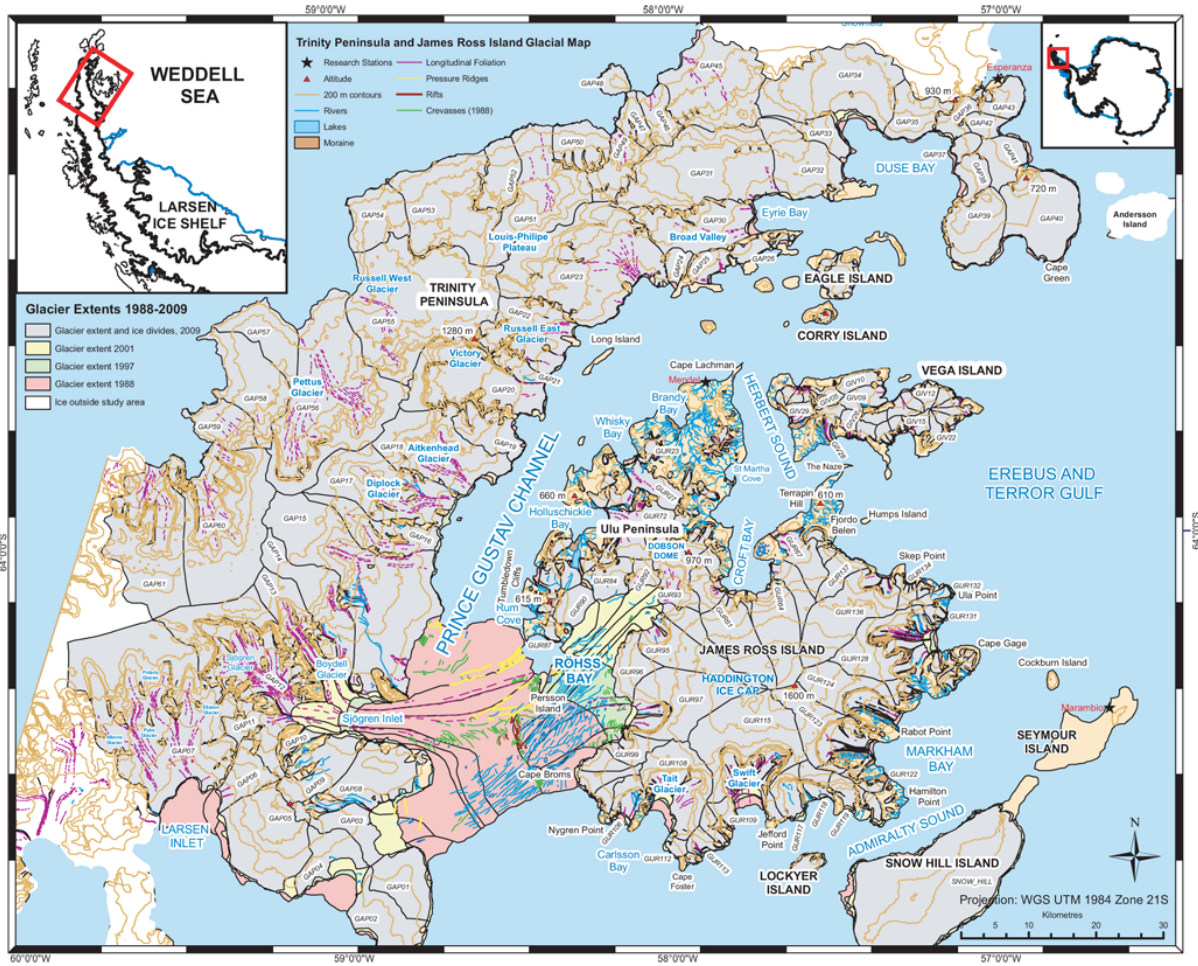
Fig. 1. Index map of the study region, showing ice divides, glacier drainage basins and glacier ID codes. Remotely sensed images (Table S1) used in making this map and all subsequent maps were projected in the Universal Transverse Mercator (UTM) projection World Geodetic System (WGS) 1984 Zone